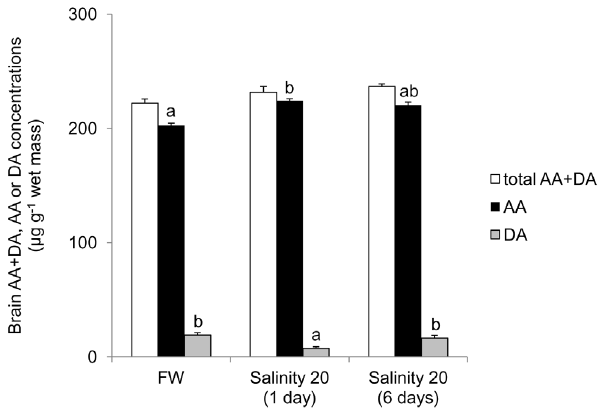
Figure 8. Concentrations ( m g g 2 1 wet mass) of ascorbate (AA; & ), dehydroascorbate (DA; & ) or AA + DA (TAA; % ) in the brain of Himanturasignifer kept in freshwater (FW) on day 0 (control), or exposed to brackish water (salinity 20) for 1 or 6 days after a 4-day progressive increase in salinity. Results represent mean 6 S. E. M. (N=4). Means not sharing the same letter are significantly different ( P , 0.05).